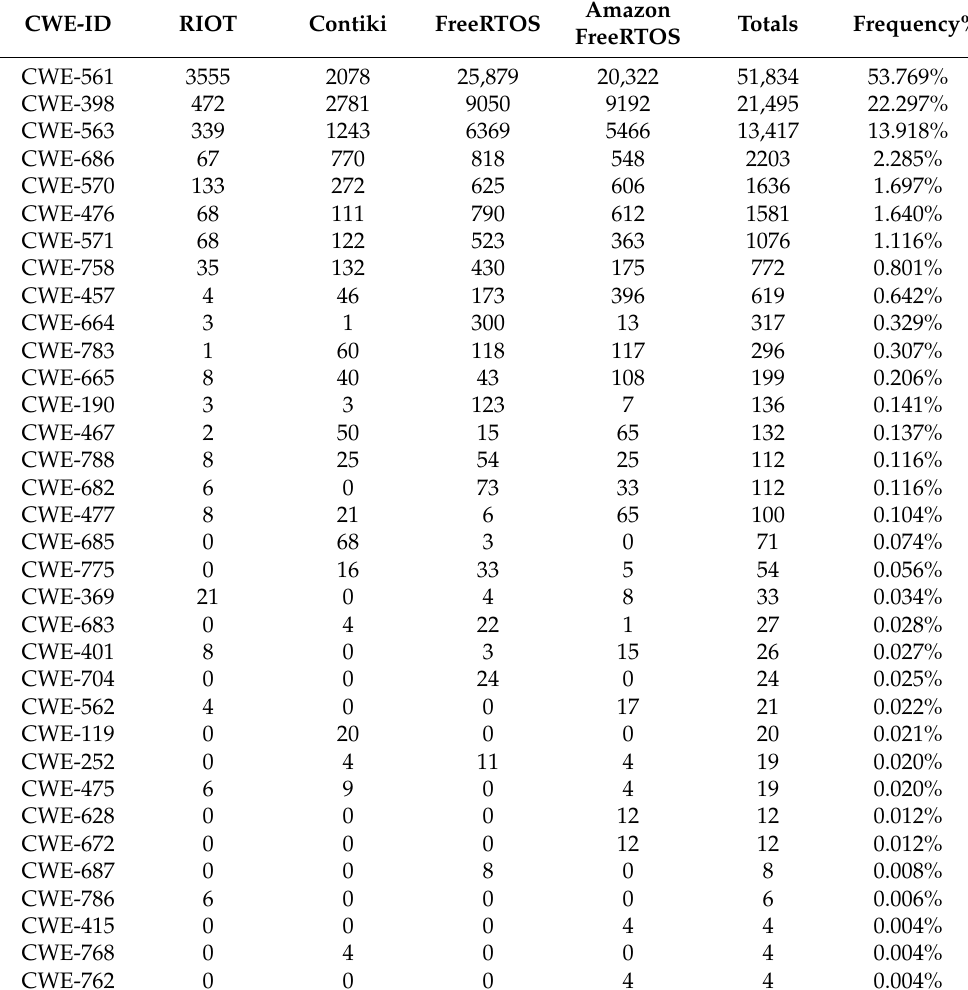
Table 8. Total CWEs of IoT OSs by Cppcheck